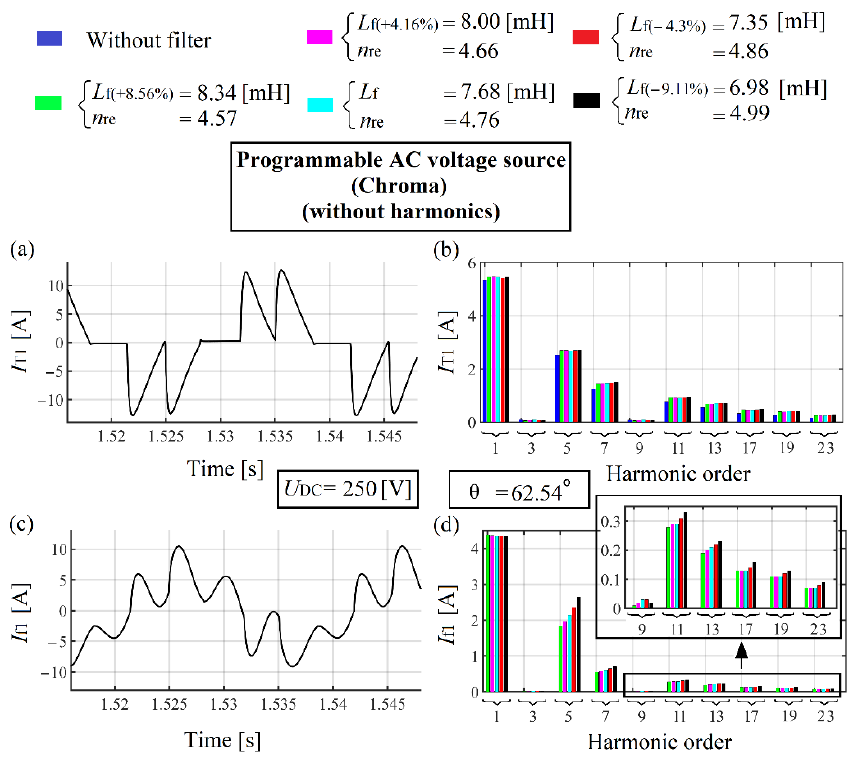
Figure 61. ( a ) Rectifier input current waveform with ( b ) the spectrum, ( c ) filter current waveform with ( d ) the